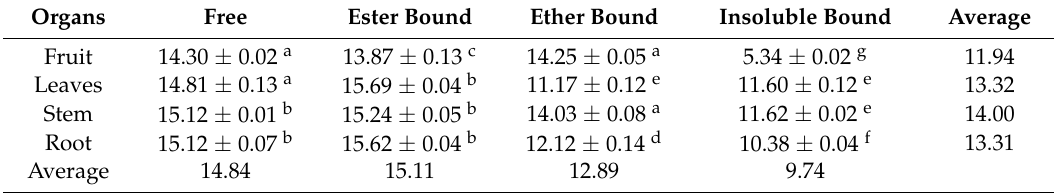
Table 1. The total phenolic contents (mg GAE/g) of extractable and non-extractable pehnolics in T.